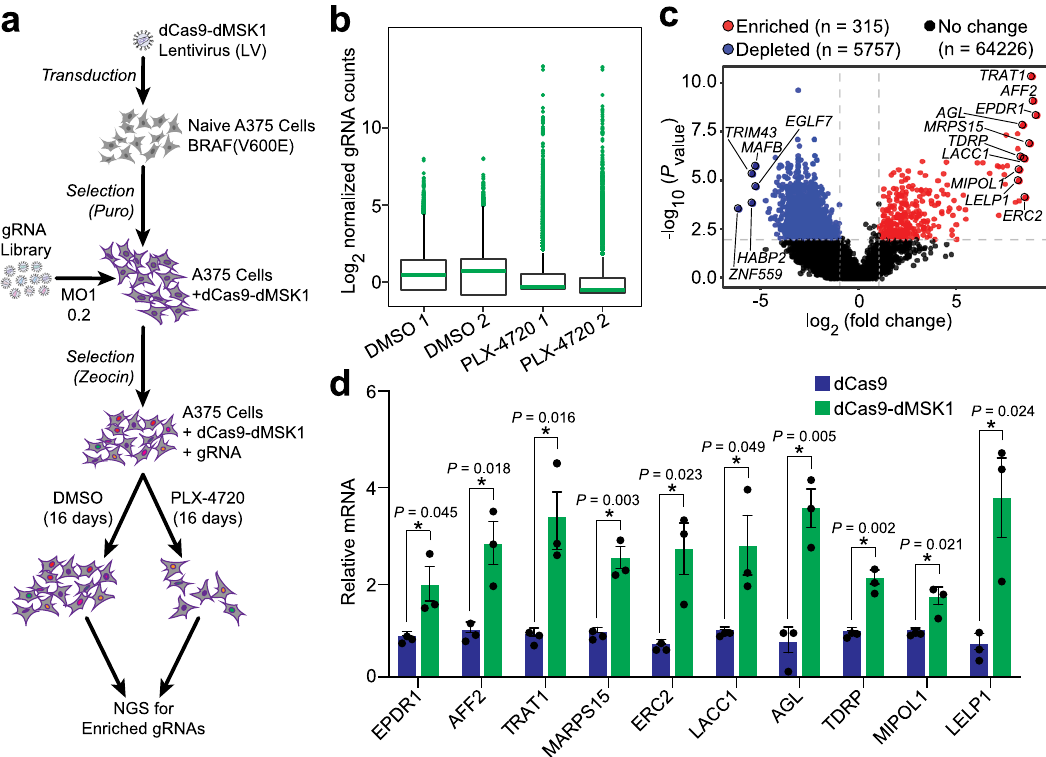
Fig. 6 Genome-scale screening using dCas9-dMSK1 identi fi es mediators of BRAF V600E inhibitor resistance. a Flow-chart of the genome-scale screening regime using dCas9-dMSK1. Puro; puromycin. b Box plots showing the distribution of gRNA frequencies after lentiviral transduction in DMSO or PLX-4720 treated A375 cells. In all box plots, the green horizontal line represents the median and the upper and lower bounds of each box correspond to the 25th and 75th percentiles of each sample, respectively. The upper and lower whiskers extend to the maximum and minimum values, respectively, within 1.5-fold of the interquartile range of the box bounds. Outliers are plotted as green dots. n = 2 independent experiments. c Volcano plot displaying gRNA counts in PLX-4720 versus DMSO treated A375 cells. Data were analyzed using robust rank aggregation (RRA) with a cutoff of P value <0.01. Blue circles indicate depleted gRNAs, red circles indicate enriched gRNAs, and gray circles indicate gRNAs with no change. d mRNA levels of the top 10 most enriched genes in A375 cells stably expressing dCas9 or dCas9-dMSK1 when targeted with corresponding gRNAs identi fi ed from the screen. Two-sided t - test, * P < 0.05; n = 3 independent experiments for panel ( d ); error bars, s.e.m. Source data are available in the Source data fi